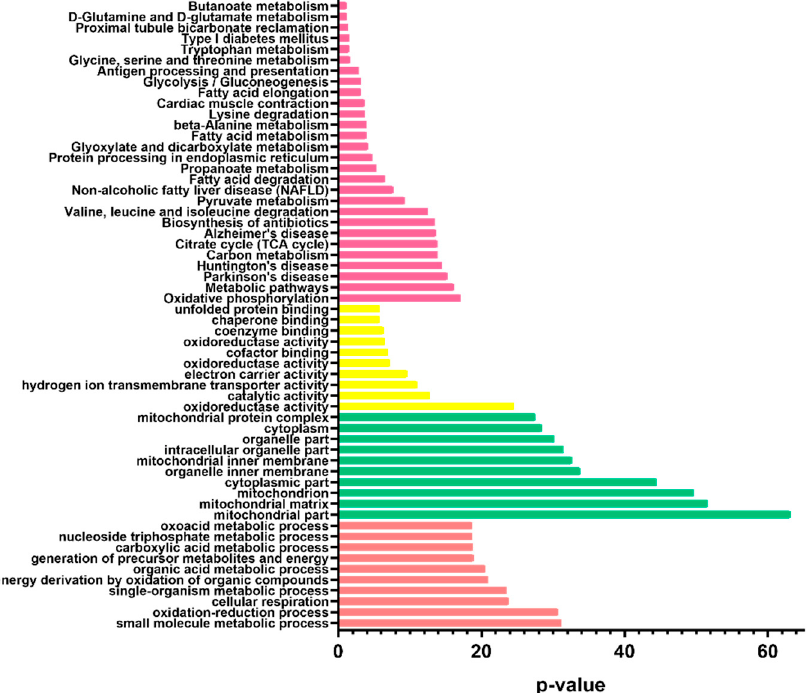
Figure 7. KEGG and GO analysis of differential proteins. The abscissa is the negative logarithm of 10 of the p –value. The red bars represent the results of the KEGG pathway, the yellow bars represent biological process analysis, the green bars represent molecular function analysis, and the pink bars represent cellular component.